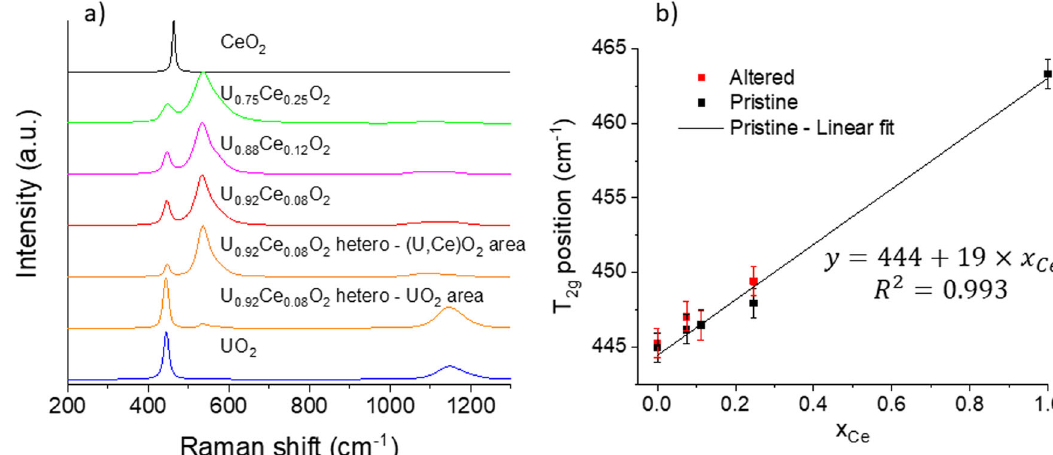
Fig. 2 Raman spectra of the prepared samples. a RAMAN spectra of pure UO 2 , CeO 2 and U 1-x Ce x O 2 pristine pellets. For the heterogeneous material: UO 2 area and (U,Ce)O 2 area correspond to the spectra of UO 2 dilution phase and Ce-rich agglomerates, respectively. b Position of the T 2g band of the U 1-x Ce x O 2± δ as a function of Ce content before and after leaching. The black line represents the linear fi t for T 2g position of pristine samples. Error bars correspond to the spectral resolution.